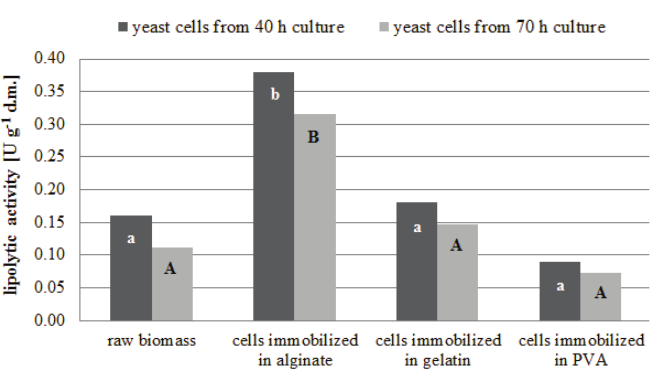
Fig. 4 – Cell-bound lipase activities of raw and immobilized yeast cells. Homogeneous groups designated on the basis of Kruskal-Wallis test were identified by letters. Means were sep- arated into statistically different groups (a, b or A, B).